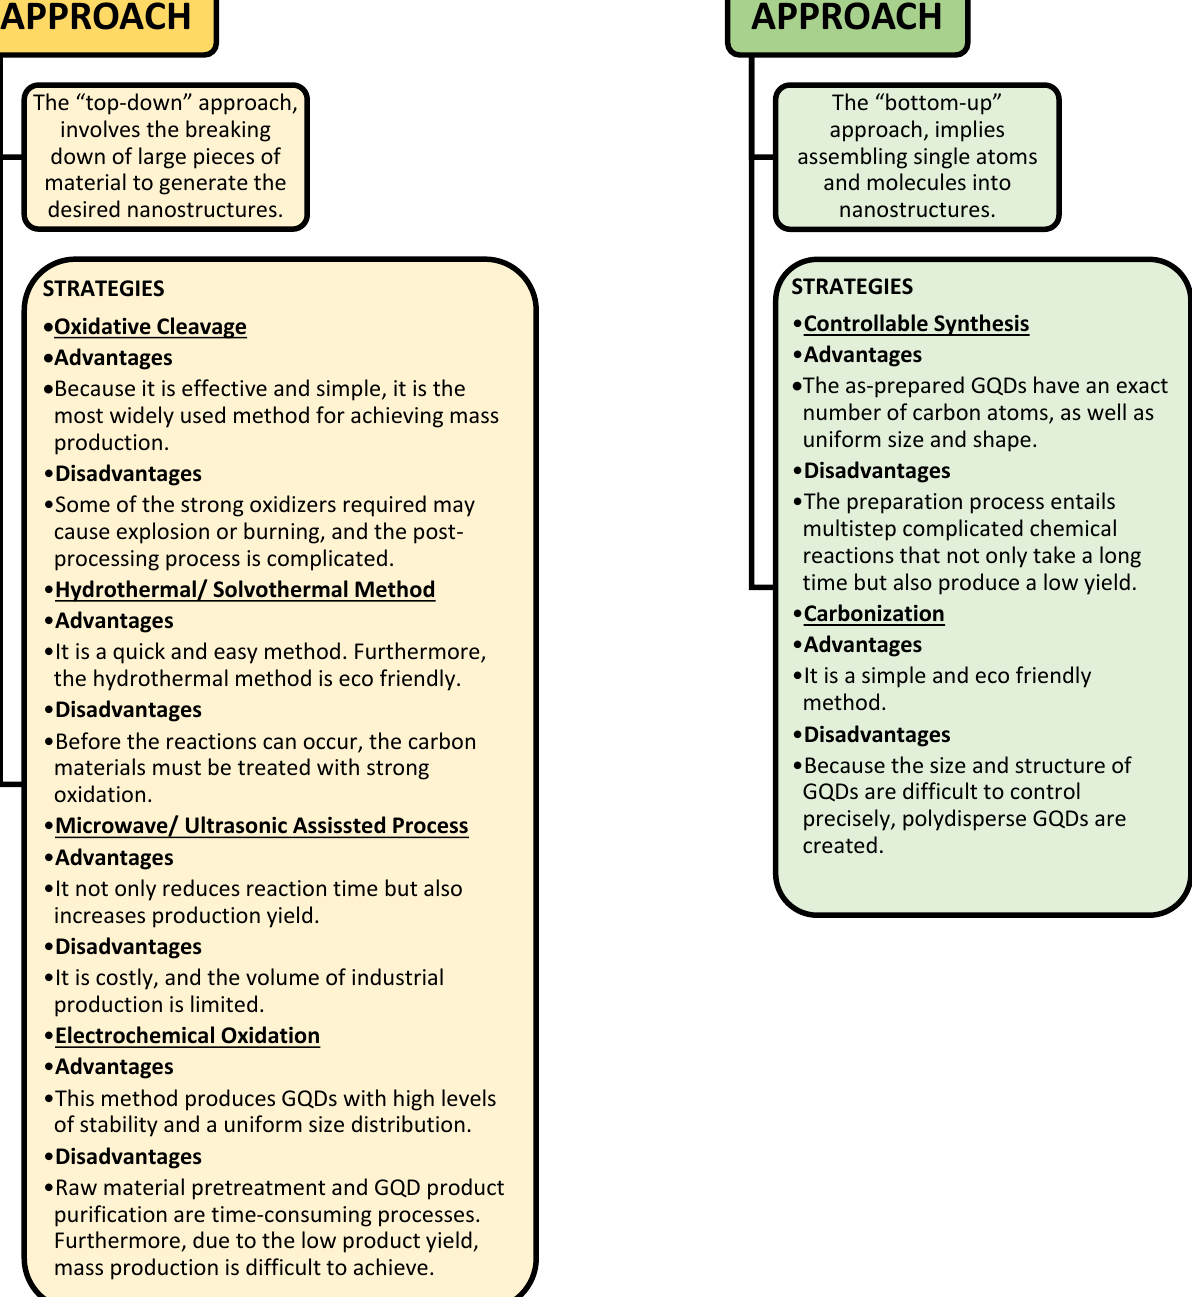
APPROACH The “bottom - up” approach, implies assembling single atoms